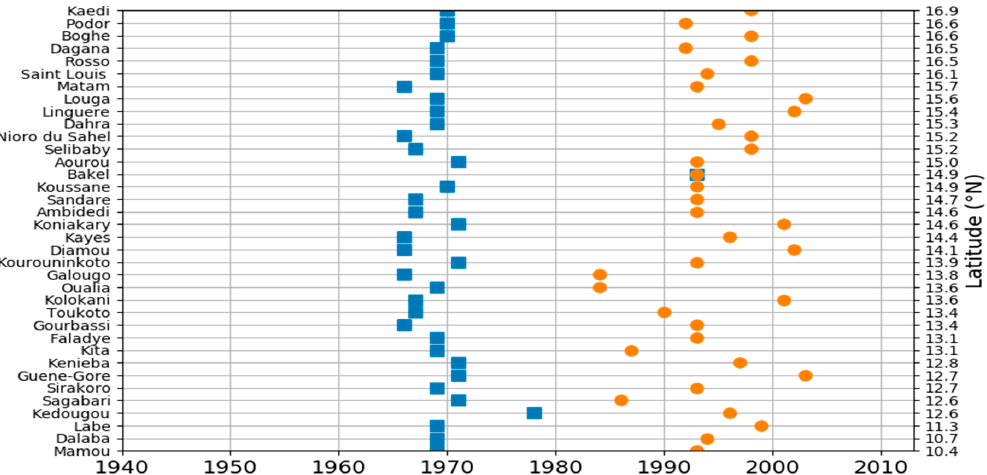
Figure 4. Breaks identified in the annual rainfall series by the Pettitt test at 5% level. The blue dots represent the year of occurrence of the first shift and the orange dots the year of occurrence of the second shift.